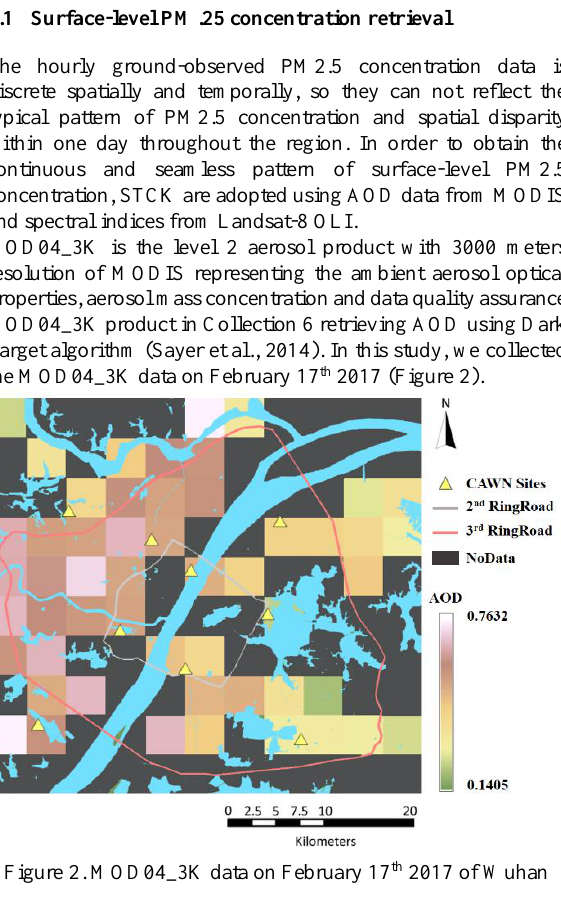
Figure 3. Surface-level PM2.5 concentration with 120 meters resolution of Wuhan Figure 3 reveals that PM2.5 concentration in the centre of